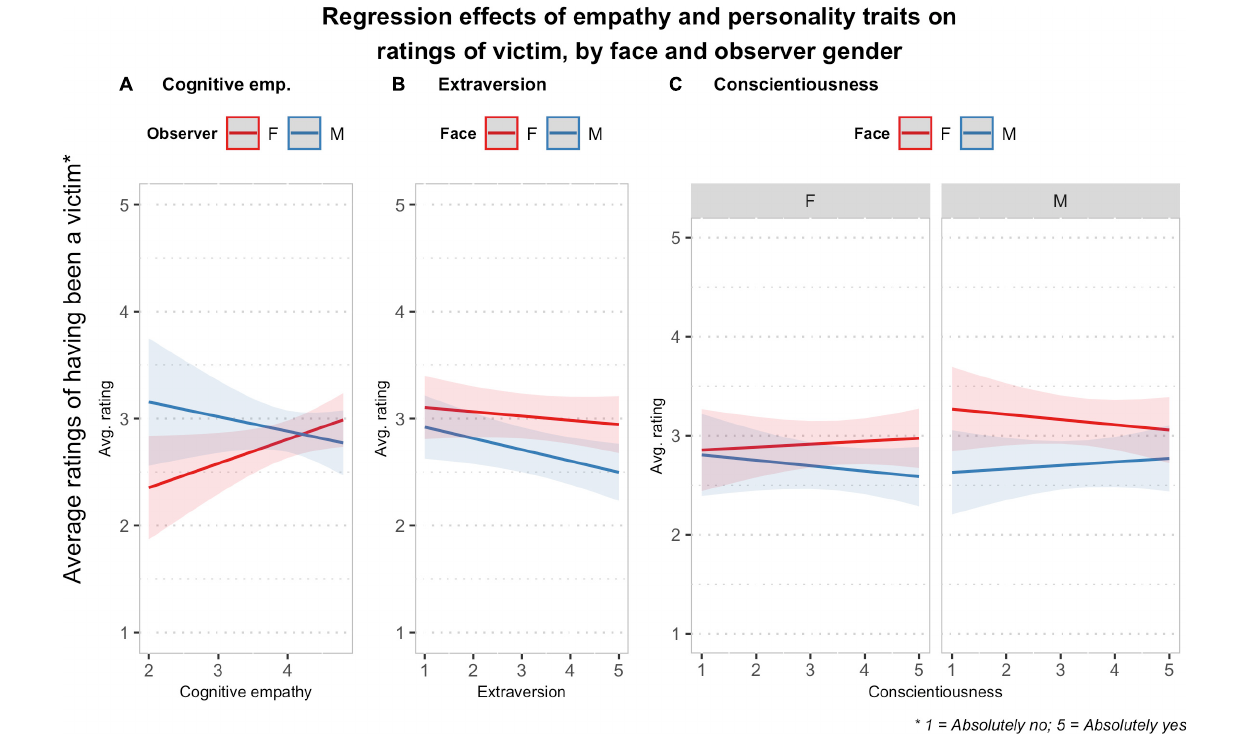
FIGURE 5 | Plots of the two-way and three-way interaction effects (i.e., regression slopes) estimated from the linear mixed-effects models including empathy (A) affective and personality variables (B) Extraversion, (C) conscientiousness as predictors of the ratings about the history of having been a victim of aggression for the persons represented in the faces.